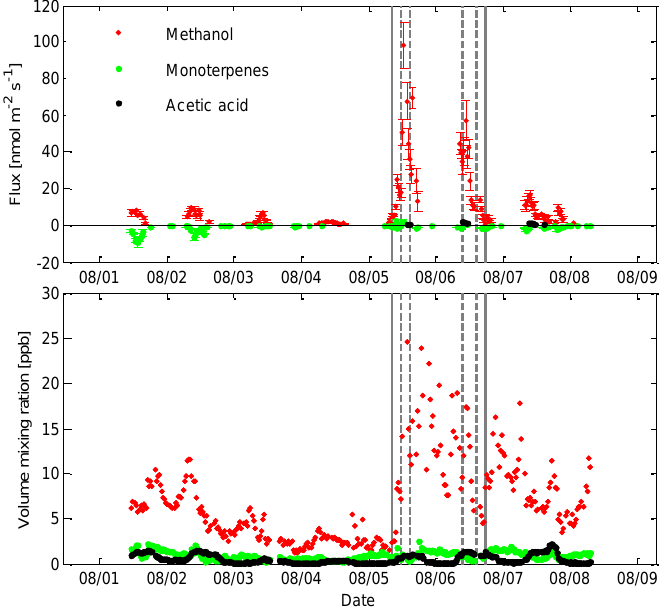
Figure 3. The temporal behavior of methanol, acetic acid and monoterpenes fluxes (upper panel) 95% confidence levels are indicated with bars, and volume mixing ratios (lower panel). Cutting of grass on 5 August morning and removal on evening of 6 August is indicated with a solid line and the turnings of the drying grass by dashed lines.